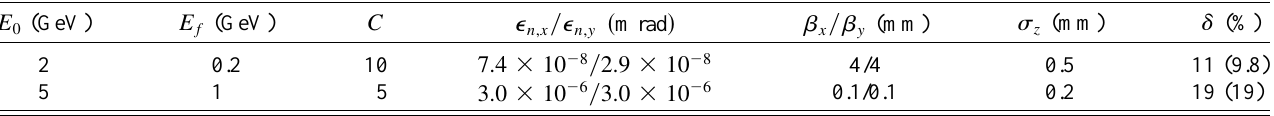
TABLE I. Parameters of the electron beams in laser-Compton cooling. The value in the parentheses is given by Telnov’s formulas. E 0 (GeV)